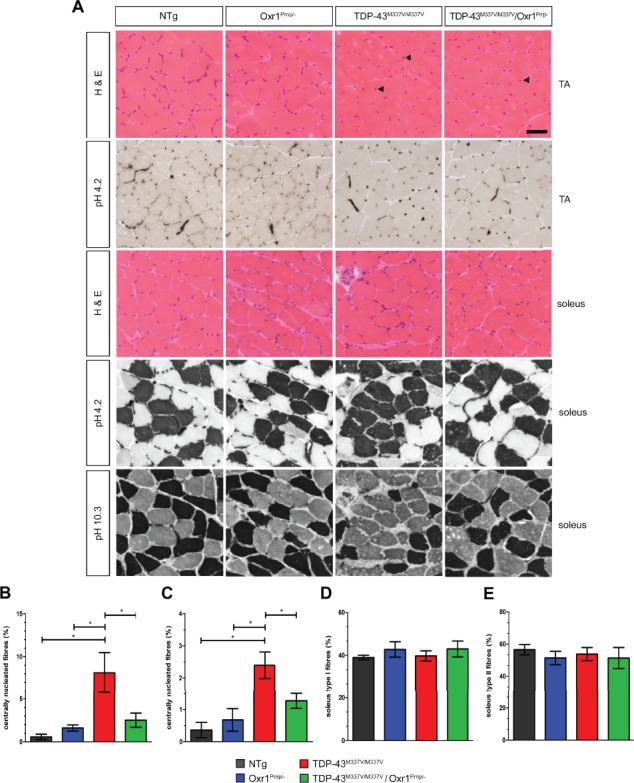
Over-expression of Oxr1 improves muscle pathology in male TDP-43M337V/M337V mice. (A) Representative images of H&E-stained TA and soleus muscle fibre cross-sections from NTg, Oxr1Prnp/−, TDP-43M337V/M337V and TDP-43M337V/M337V/Oxr1Prnp/− mice at 18 months of age. Examples of centrally nucleated fibres are indicated (arrowheads). Representative images of ATPase staining for muscle fibre types using the preincubation pH conditions as indicated are also shown; pH 4.2, type I fibres dark staining and type II fibres light staining; pH 10.3, type I fibres light staining and type II fibres dark staining. (B and C) The percentage of centrally nucleated fibres per section is significantly increased in TDP-43M337V/M337V mice in both TA (B) and soleus (C), which is rescued by over-expression of Oxr1. (D and E) Quantitation of fibre-type staining in the soleus reveals no significant differences in the proportions between genotypes, although fibre-type grouping is observed in TDP-43M337V/M337V mice (A). Values are shown as the mean ± SEM. N = 3–5 male animals per genotype. *P < 0.05, One-way ANOVA with Dunnett’s multiple comparison test comparing each group to TDP-43M337V/M337V mice. Scale bar: 100 μm.